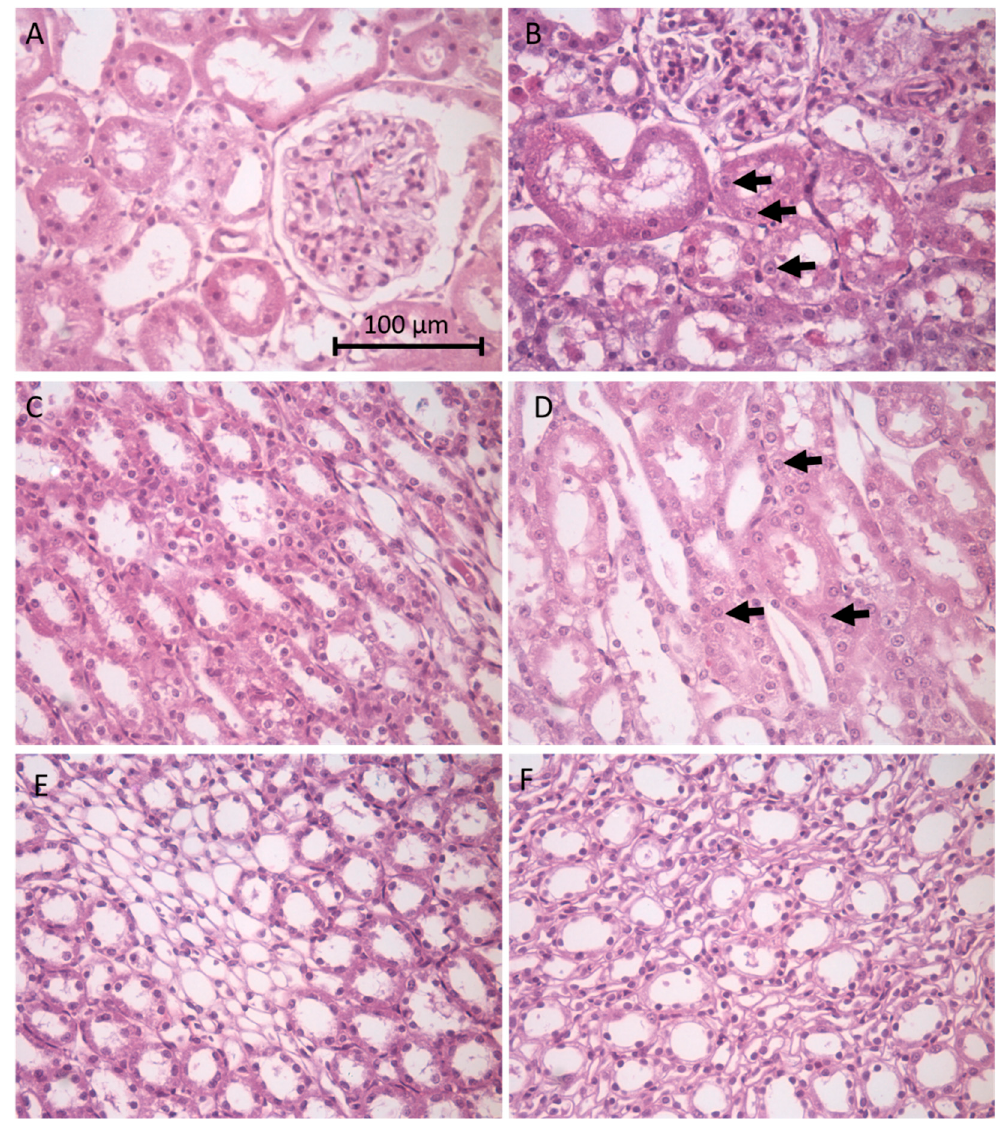
Figure 1. Histological changes in the di ff erent regions of the kidney following treatment of site-specific nephrotoxicants. Following treatment, kidney tissue was collected and later sectioned to 5 µm thick sections, then stained with hematoxylin and eosin. Images are representative images from male Sprague/Dawley rats treated with the proximal tubule/cortex nephrotoxicant gentamicin (100 mg/Kg/day i.p. for 8 days). H&E histological sections of renal cortex are shown in panels A (control) and B (treated). The distal tubule/medulla toxicant amphotericin B (15 mg/Kg/day i.p. for 5 days), renal medula is shown in panels C (control) and D (treated). Lastly, collecting duct/papilla nephrotoxicant indomethacin (single dose 20 mg/Kg p.o.), renal papillae is shown in panels E (control) and F (treated). Arrows indicate nuclear condensation, indicative of apoptosis. Scale bar in panel A is 100 microns in length; all images are of the same magnification.